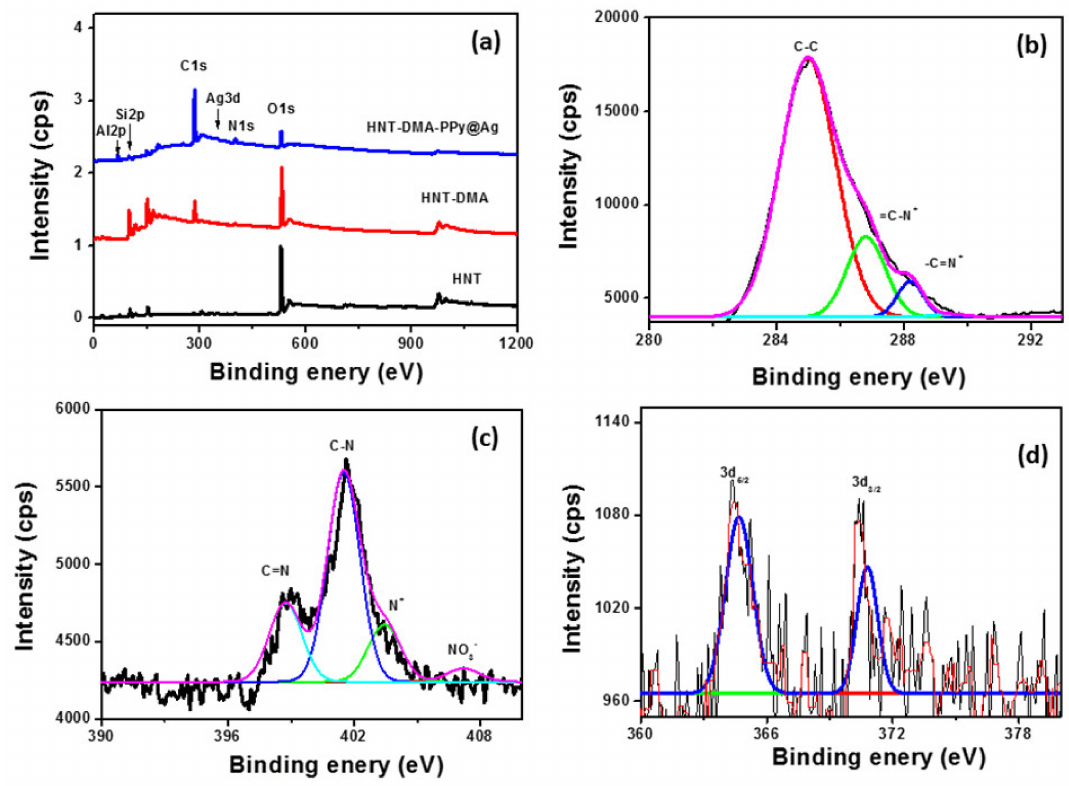
Figure 6. ( a ) XPS survey regions of HNT, HNT-DMA, and HNT-DMA-PPy@Ag, High resolution ( b ) C1s, ( c ) N1s, and ( d ) Ag 1d regions from modified halloysite